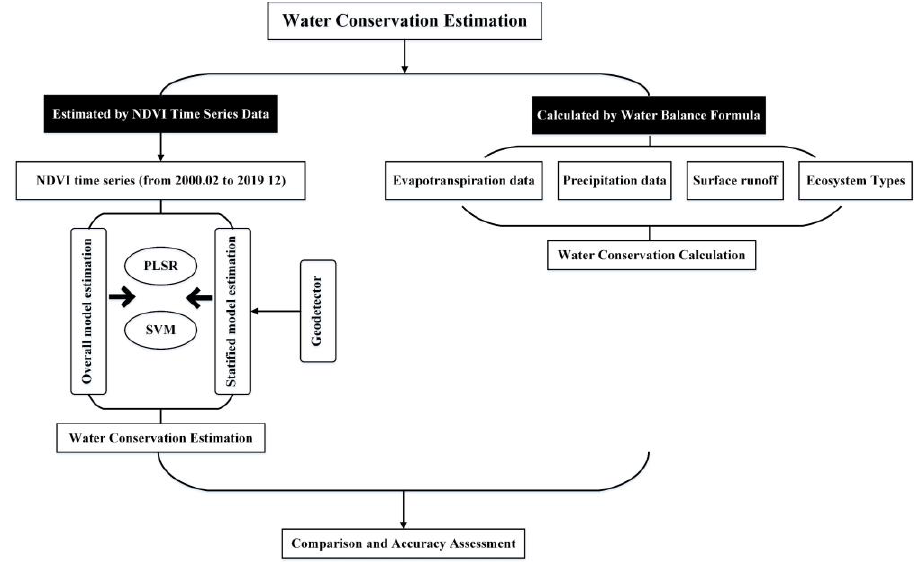
Figure 3. Diagram of the research process. Note: PLSR, partial least squares regression and SVM, support vector machine.